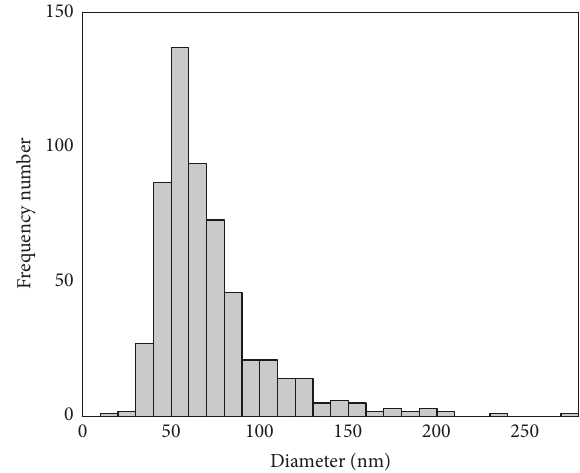
Figure 5: Histogram of the particles obtained at pH of 1.75, 15 ∘ C, 0.08 g of TW80, 1g of ECA, and 0.25 g of